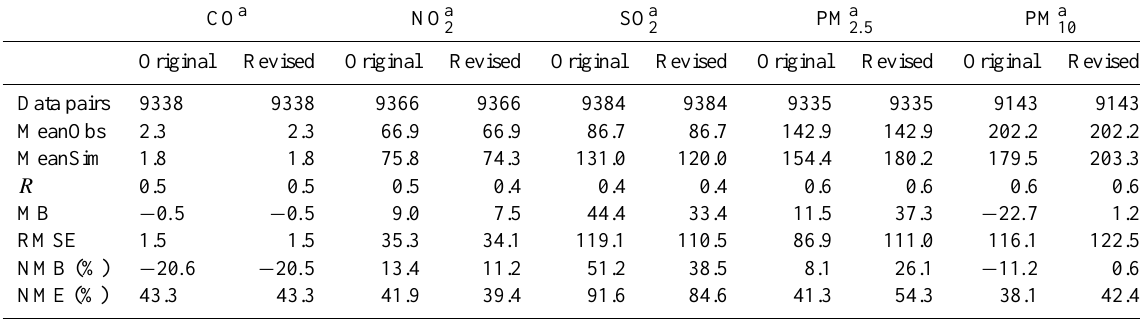
Table 8. Domain-wide performance statistics of the original and revised CMAQ.